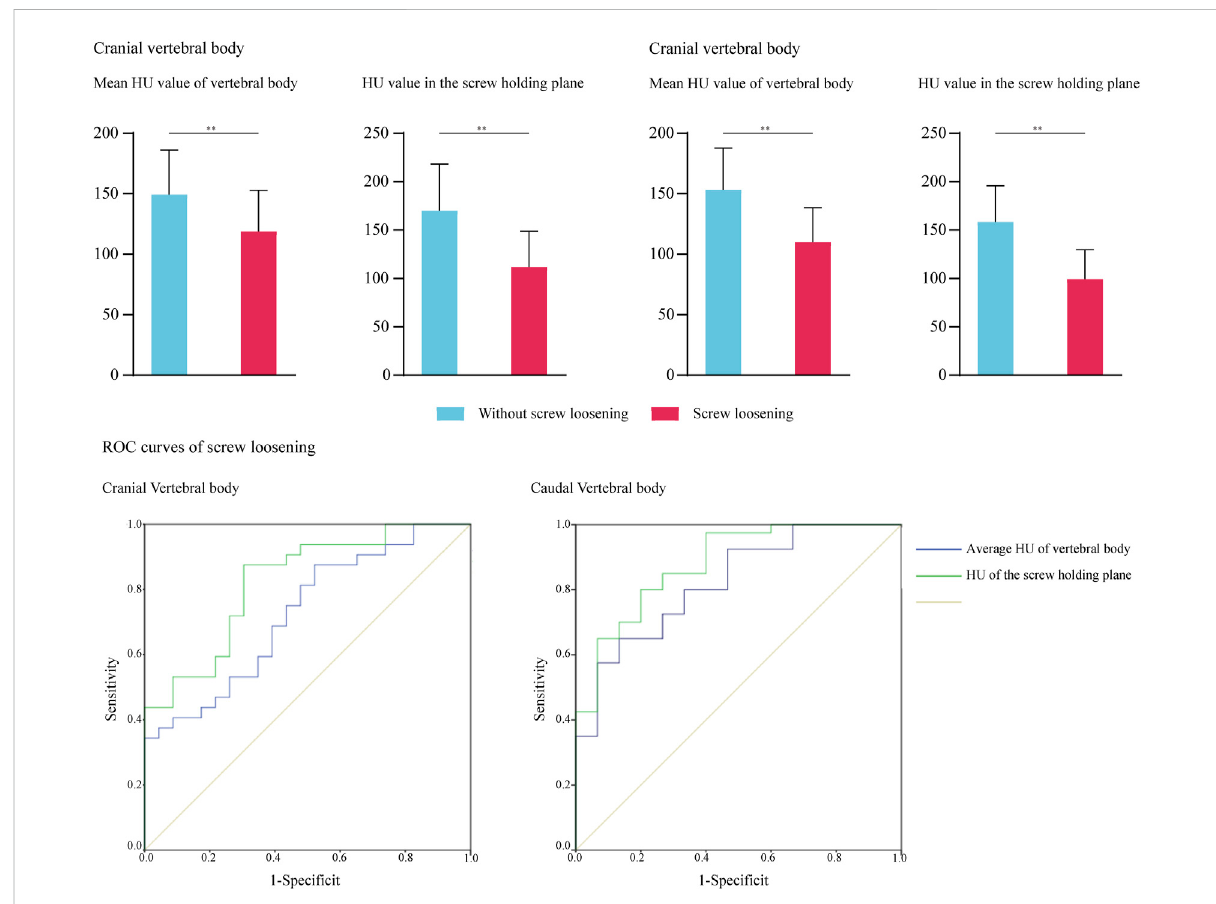
FIGURE 3 ROC curves for cranial and caudal side screw loosening and signi fi cant difference for HU in groups with credible screw fi xation and screw